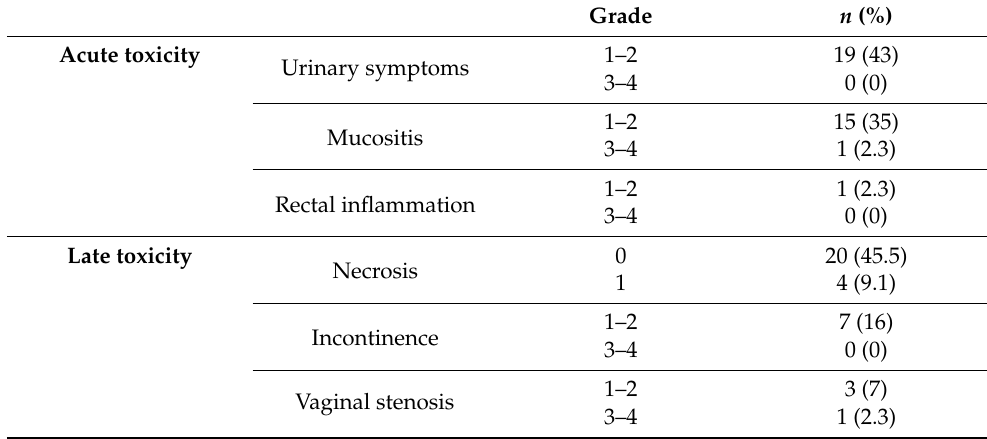
Table 3. Toxicities according to the Common Terminology Criteria for Adverse Events version